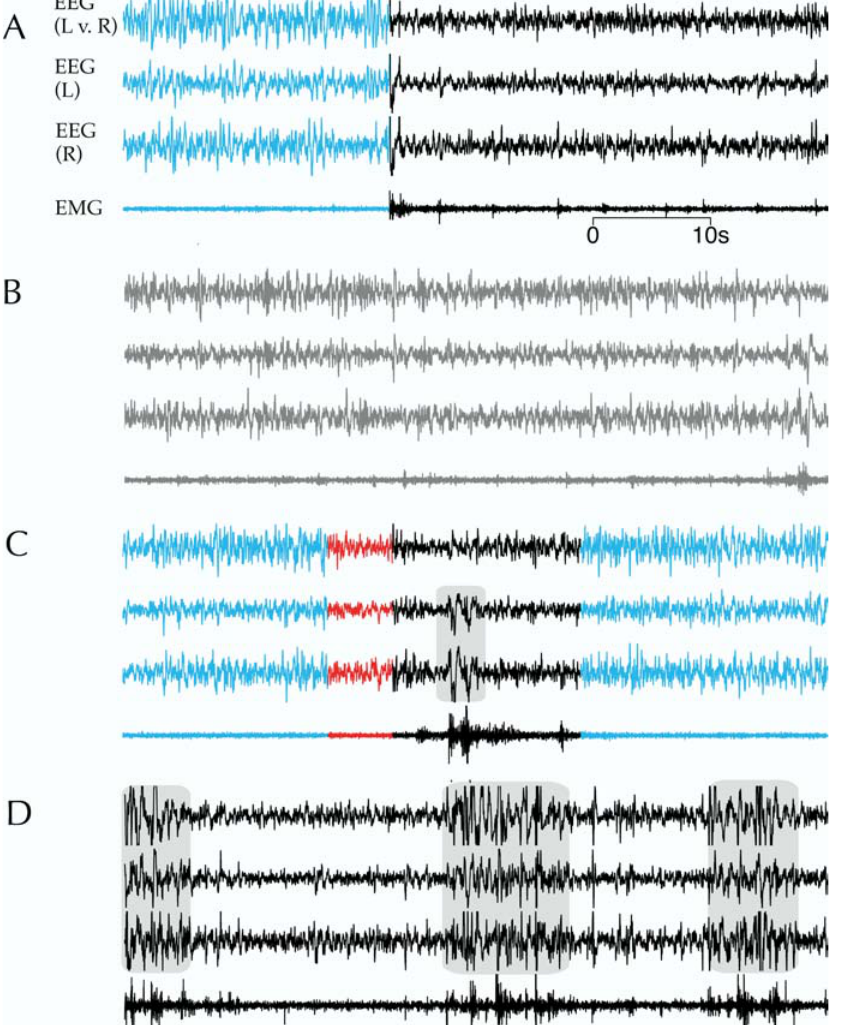
Figure 2. Examples of Electrophysiolog- ical Correlates of Behavioral States This figure shows four 1-min samples each containing three EEG recordings (left hemisphere vs. right hemisphere [L v. R], left hemisphere vs. neutral refer- ence [L], and right hemisphere vs. neutral reference [R]) and one EMG from one sparrow (no. 65) depicting the typical electrophysiological correlates of each behavioral state. (A) Transition from SWS (blue) to wakefulness (black). (B) Drowsiness (gray). (C) Transition from SWS (blue) to a bout of REM sleep (red), and then a brief awakening (black), followed by a return to SWS (blue). (D) Wakefulness during a period of migratory restlessness. High-amplitude artifacts associated with gross movements are shaded with a gray background. (A–C) were recorded on 11 August 2003, during the summer while the bird was in a nonmigratory state, and (D) was recorded on 11 October 2003, during the fall migratory